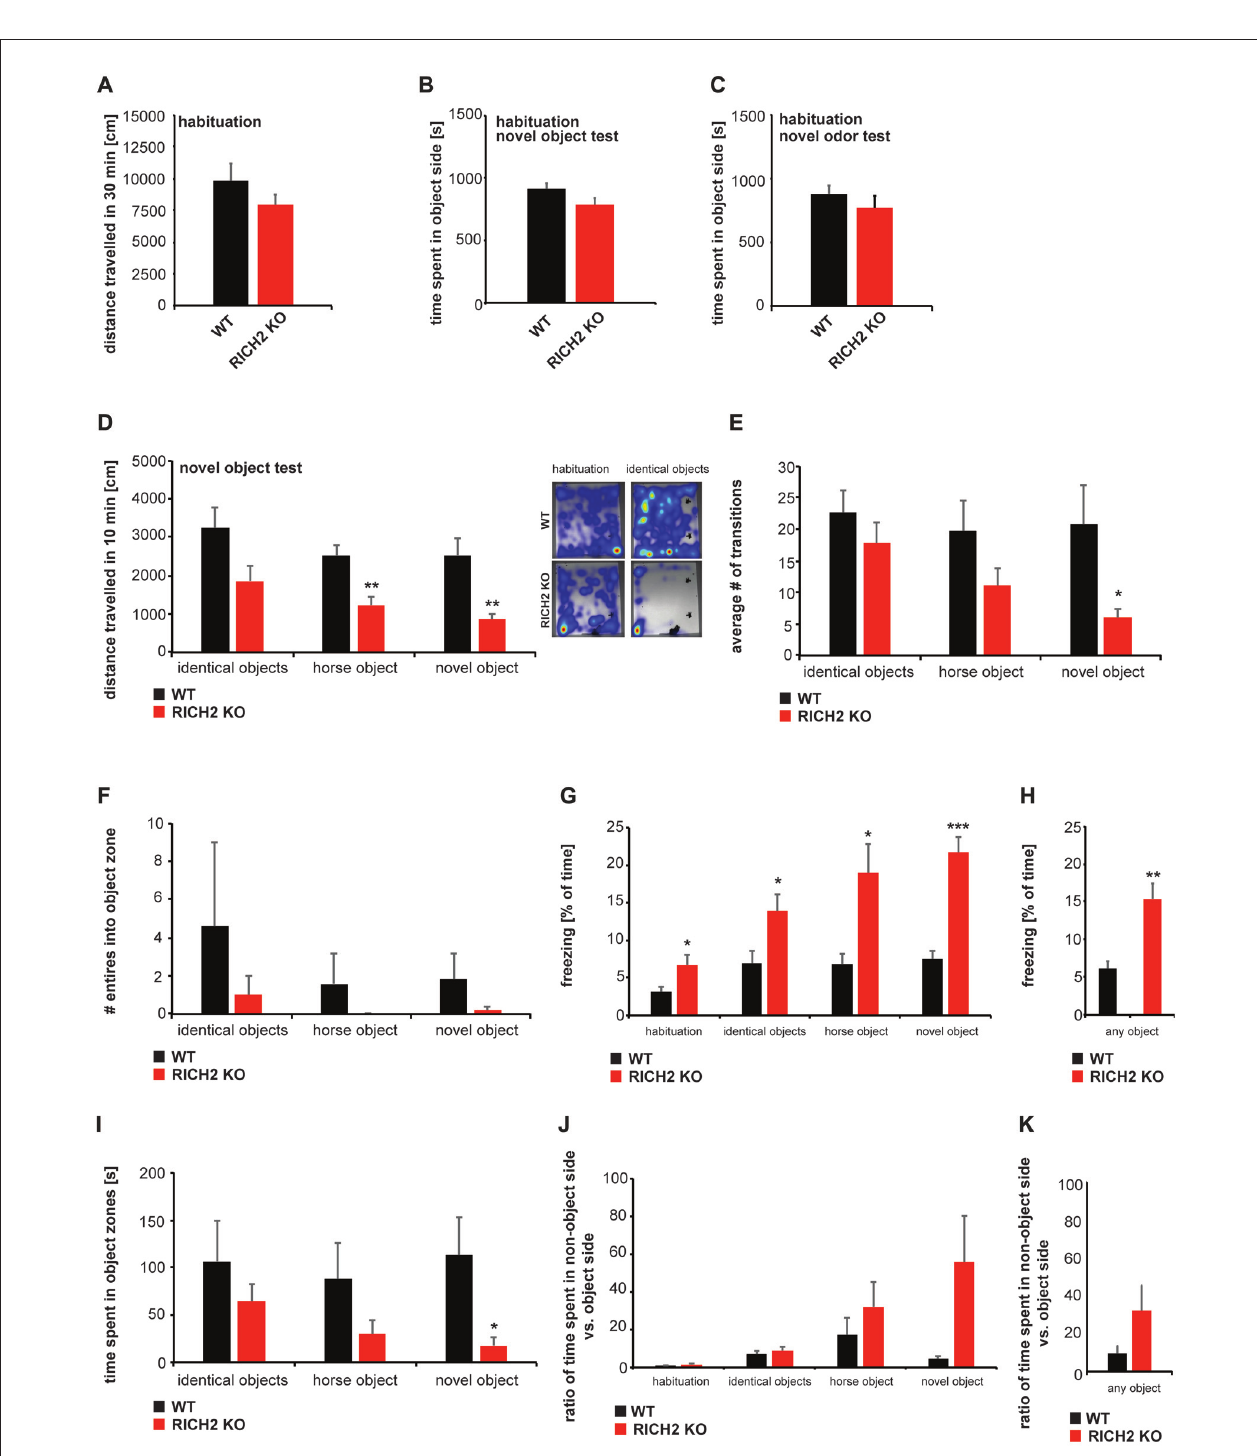
FIGURE 2 | Normal motivation to explore but object neophobia in RICH2 KO mice. (A–K) Habituation to the test arena for the novel object test and exposure to novel odors was evaluated in WT and RICH2 KO mice. Habituation was performed for 30 min. (A) No significant difference in the distance traveled was detected between RICH2 KO and WT mice in the habituation phase in the open field used for odor exposure. (B) No innate side preference was detected for the test arena of the novel object test and odor test, and no difference in the time spent in the designated objet (B) or odor (C) zone was found (unpaired t -test, p = 0.1034 for (B) , p = 0.3718 for (C) , n = 5 for each group). (D) During the 10 min of exposure to objects (identical objects, one novel object, and horse shaped object), RICH2 mice showed differences in the distance traveled compared to WT mice. A decrease was seen in response to novel objects (as trend) and a significant decrease